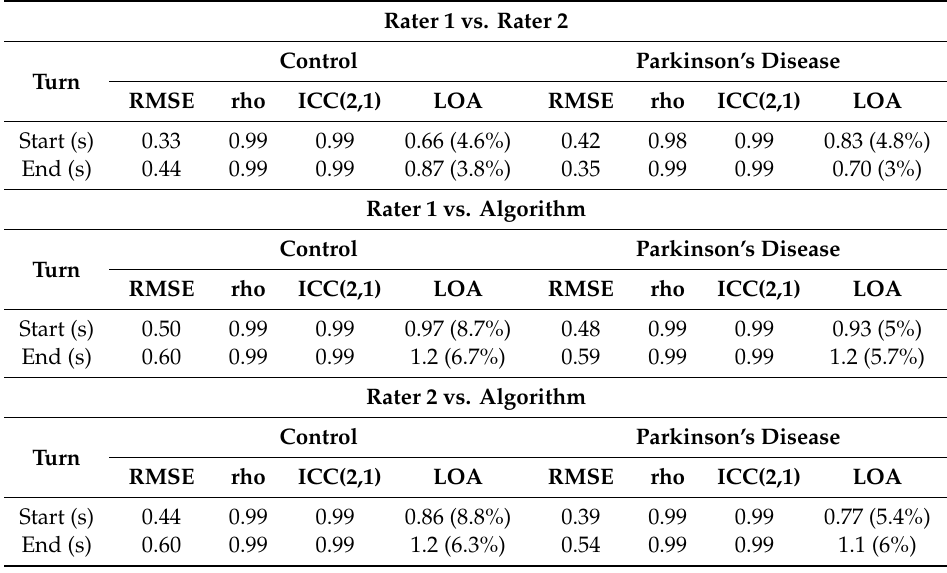
Table 2. Statistics for validation of turning algorithm for control (n = 40) and PD (n =